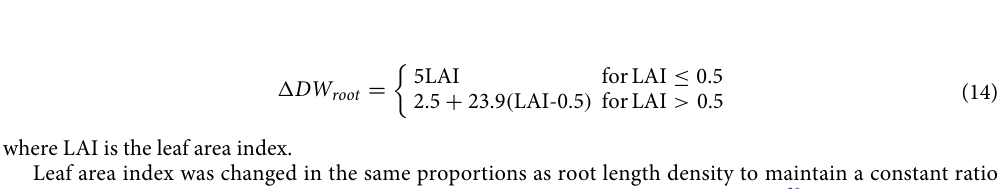
Table 1. The input parameters of calculate total production costs of basil plants grown in different soilless